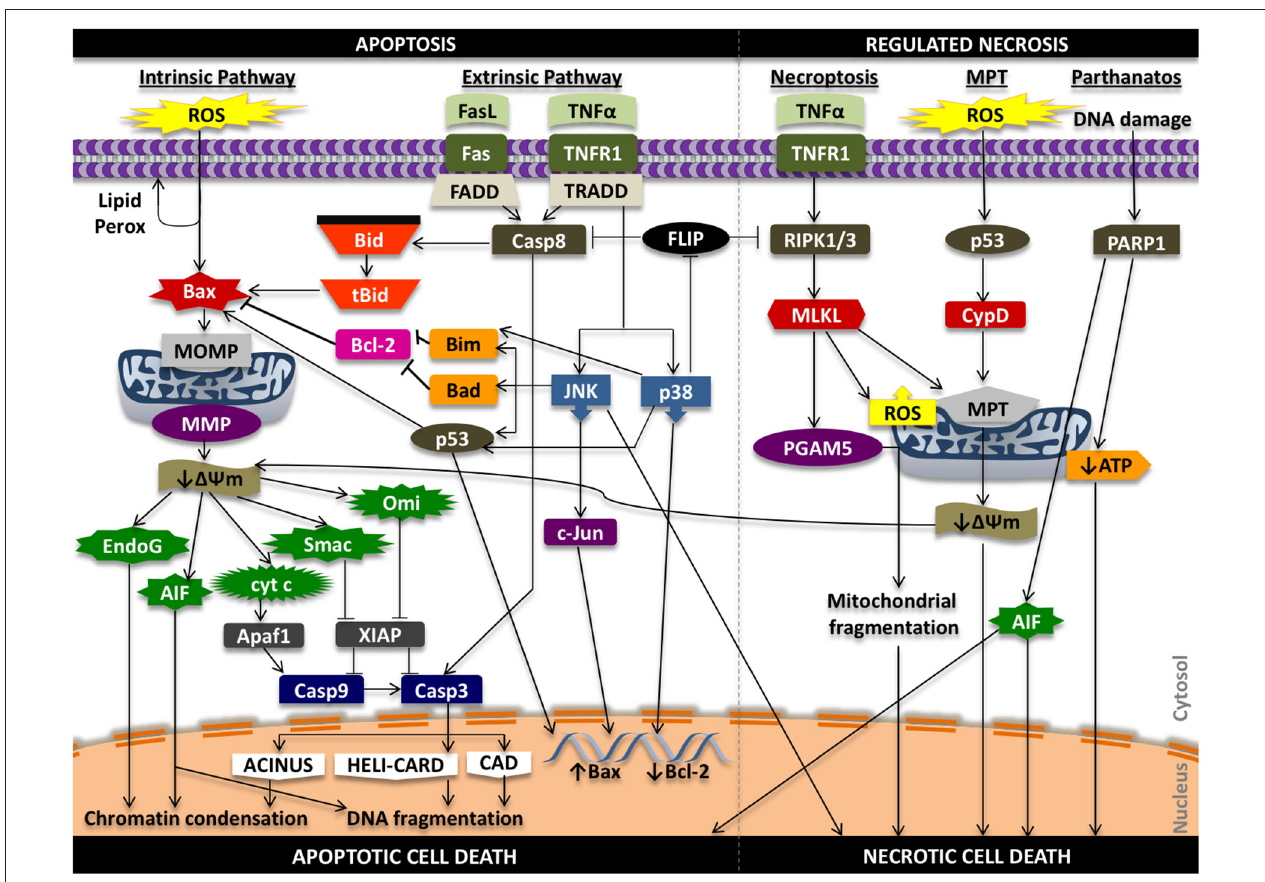
factors that increase pro-death and reduce pro-survival gene expression. Activation of TNFR1 can also initiate a RIPK1 and RIPK3-dependent form of regulated necrosis (necroptosis) through regulation of PGAM5, ROS, and the mitochondrial permeability transition (MPT). MPT-mediated regulated necrotic cell death can be triggered following oxidative stress; downstream signaling results in activation of cyclophilin D (CypD), increased permeability of the inner mitochondrial membrane, and mitochondrial swelling and rupture that promotes necrosis. Alterations in the transmembrane potential of